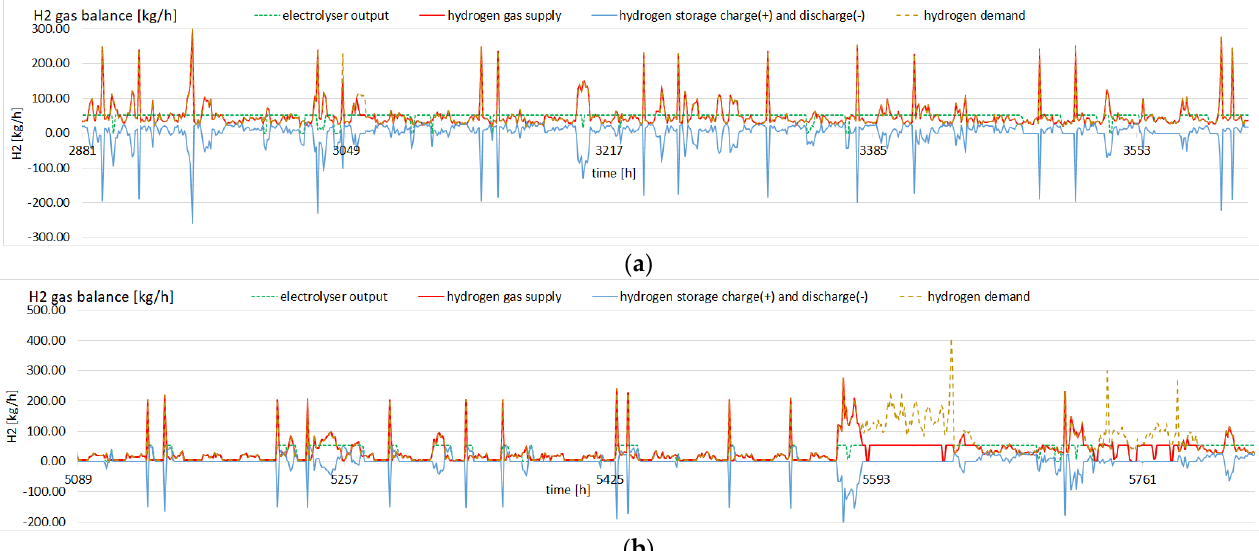
Figure 5. Case hydrogen flows (simulation results). ( a ) May; ( b ) August.